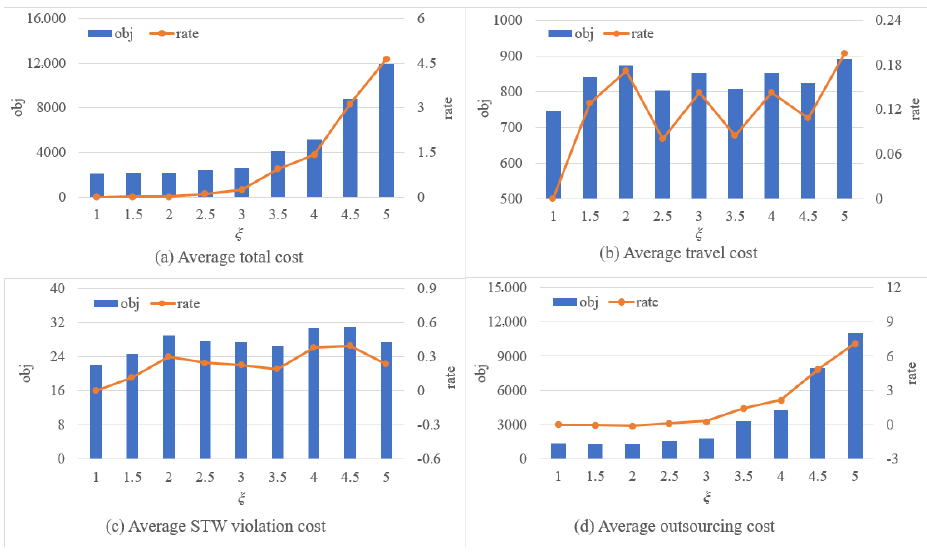
Figure 4. Comparison results with different ξ